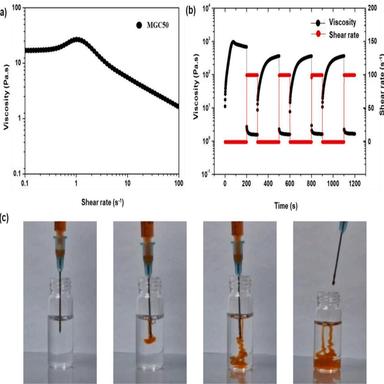
(a) The viscosity versus shear rate behavior of MGC50 at 25 ◦C, (b) Changes of viscosity with time at alternant shear rates of 0.1 s − 1 and 100 s − 1 at 37 ◦C, and (c) photographs showing the injectability of MGC50 thermogel through a syringe and subsequent thermogelation in PBS at 37 ◦C.